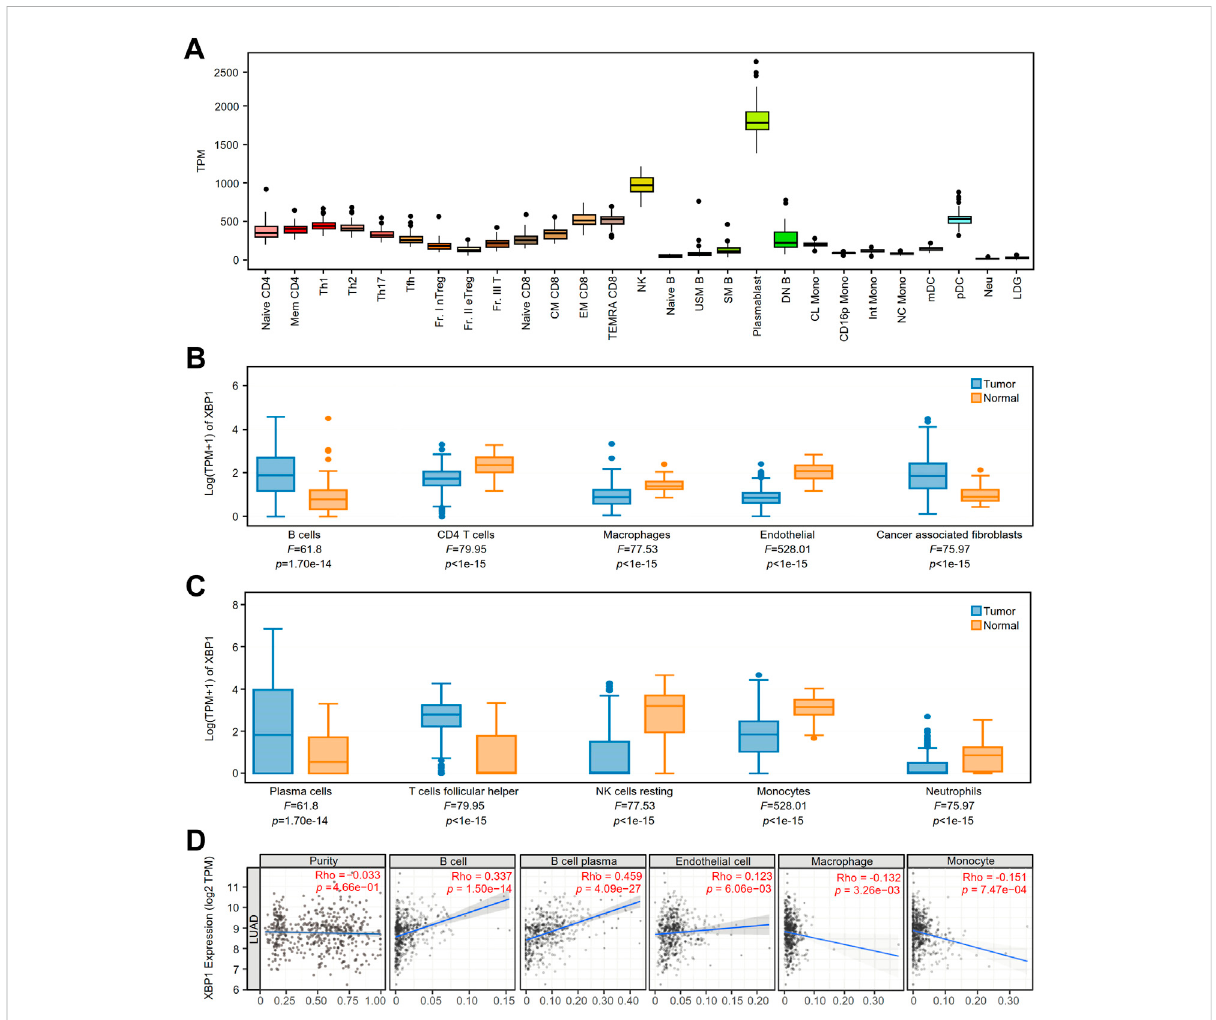
FIGURE 4 The expression of XBP1 in various immune cells and its association with immune in fi ltration in LUAD. (A) XBP1 expression atlas of immune cells of healthy individuals from the ImmuNexUT. (B,C) The expression of XBP1 in different immune cells in LUAD and adjacent peritumor normal tissues were analyzed based on EPIC (B) and CIBERSORT (C) using GEPIA 2021. (D) Correlative expression of XBP1 with LUAD purity and in fi ltration of immune cells, including B cells, plasma cells, endothelial cells, macrophages and monocytes in